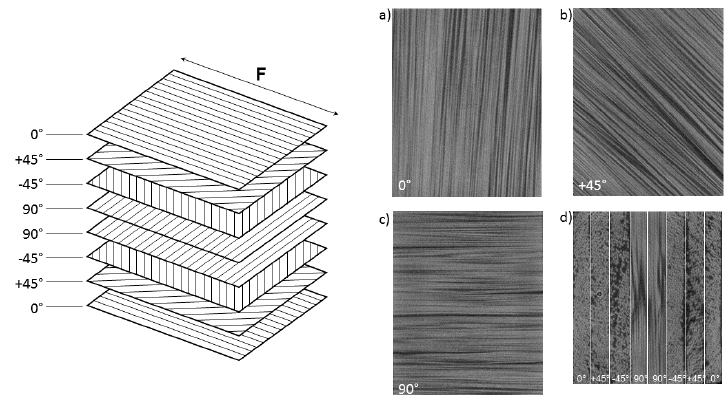
Figure 1. Sketch of the specimen layout to form the quasi-isotropic laminate with CT images of the respective layers. Naming of the fiber orientation is with respect to the direction of the applied tensile force (F). Major orientations are 0° ( a ), ±45° ( b ) and 90° ( c ). In an axial CT image ( d ) all eight individual plies are visible.